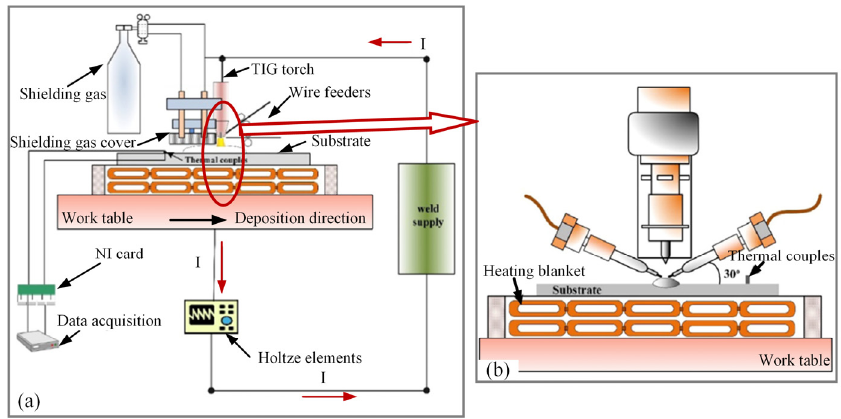
Figure 15. ( a ) Schematic of WAAM system, ( b ) Schematic of double-wire-feeding units [72].